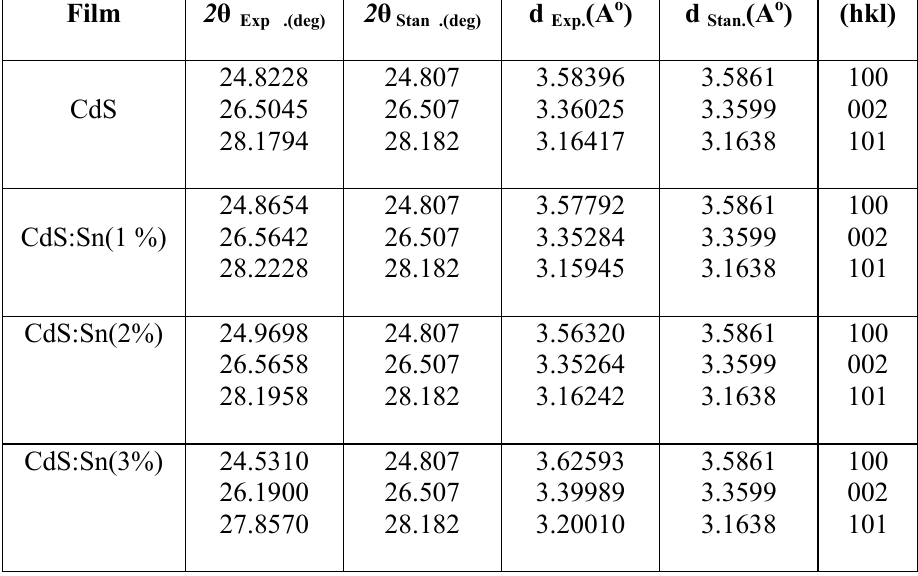
Fig. 1: XRD pattern of CdS and CdS:Sn thin film. Table 1: The strucural parameters of CdS:Sn thin